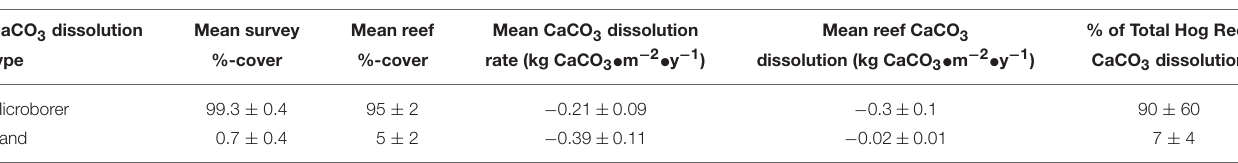
TABLE 2 | Summary table of CaCO 3 dissolution at Hog